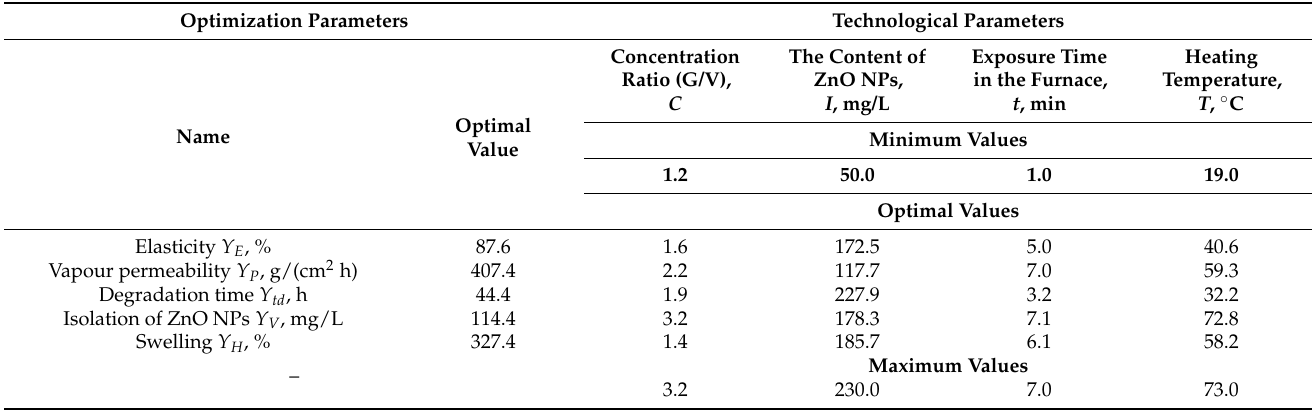
Table 2. Optimal values of technological parameters of the film formation process.